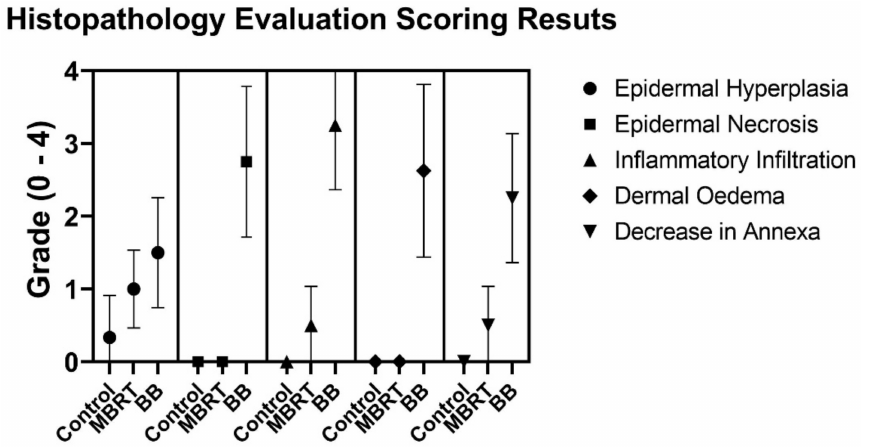
Figure 7. Histology evaluation scoring results showing mean values and standard deviations for the different irradiation modes.